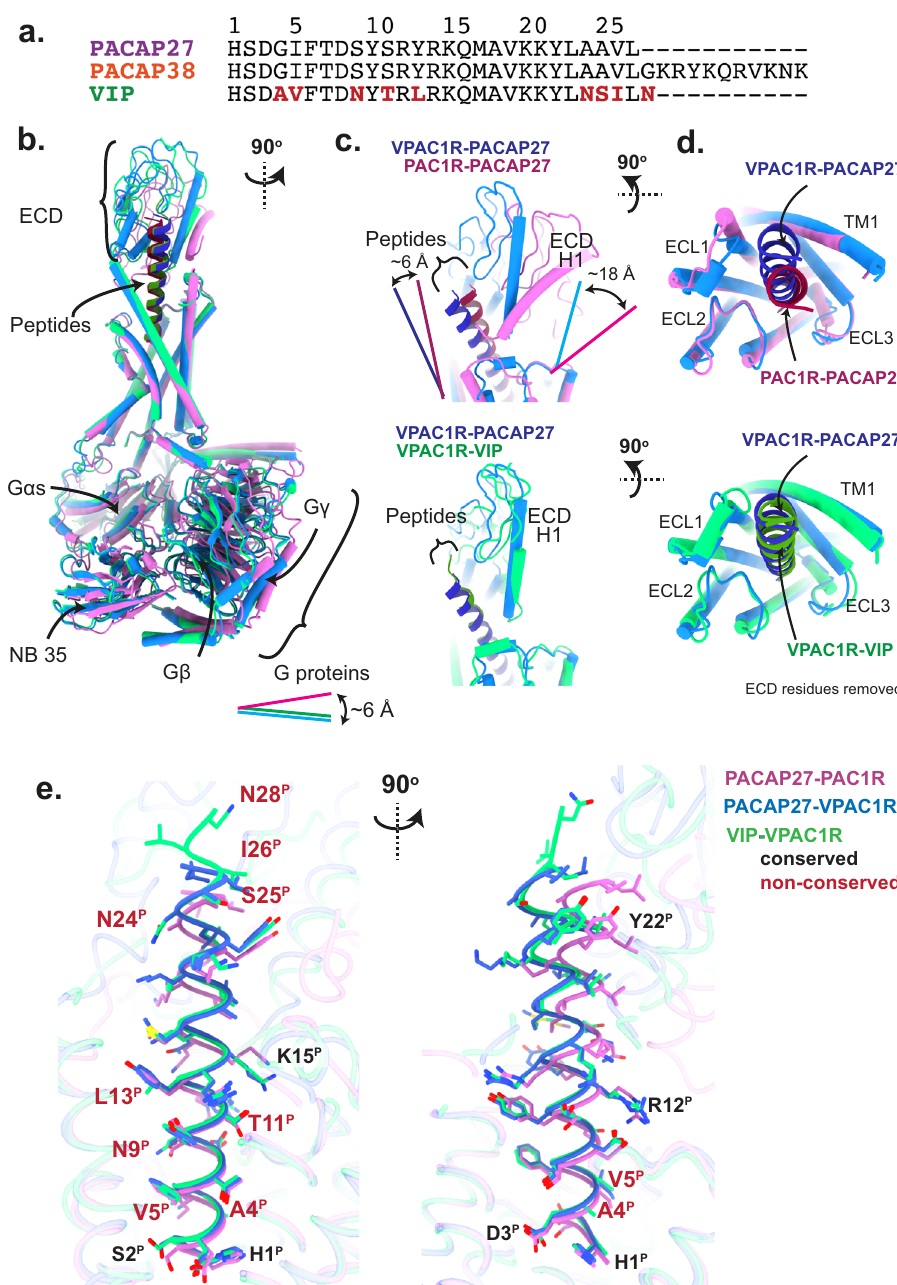
Fig. 1 | Overview of active, Gs-coupled PACAP family complexes solved using cryo-EM. a Sequence alignment of endogenous PACAP family peptides PACAP27, PACAP38 and VIP, with non-conserved VIP residues shown in red. b – d Secondary structure comparison of Gs complexes of PAC1R-PACAP27 (pink, peptide: dark red), VPAC1R-VIP (light green, peptide: dark green) and VPAC1R-PACAP27 (light blue, peptide: dark blue). Secondary structure is shown as ribbon for the peptide helix and as cylinders (helices) and beta sheets for the rest of the complex. Com- plexesareshownindifferentanglesasfrontviewoftheentirecomplex( b ,allthree structures), side view of the extracellular domain (ECD) and peptide C-terminus ( c ,PACAP27boundstructurestoppanel,VPAC1Rstructuresbottompanel)andtop view of the receptor bundle, extracellular loops (ECL) and peptide C-terminus